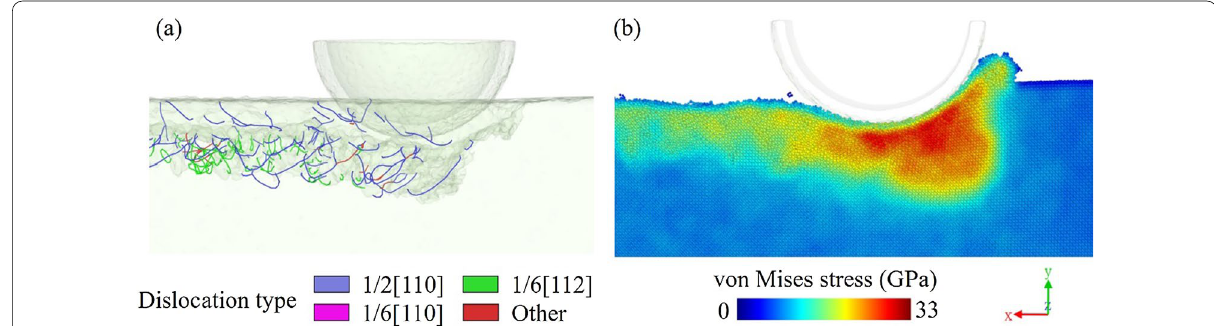
Fig. 6 a Dislocation distribution and b von Mises stress distribution in the subsurface of the nano-cutting